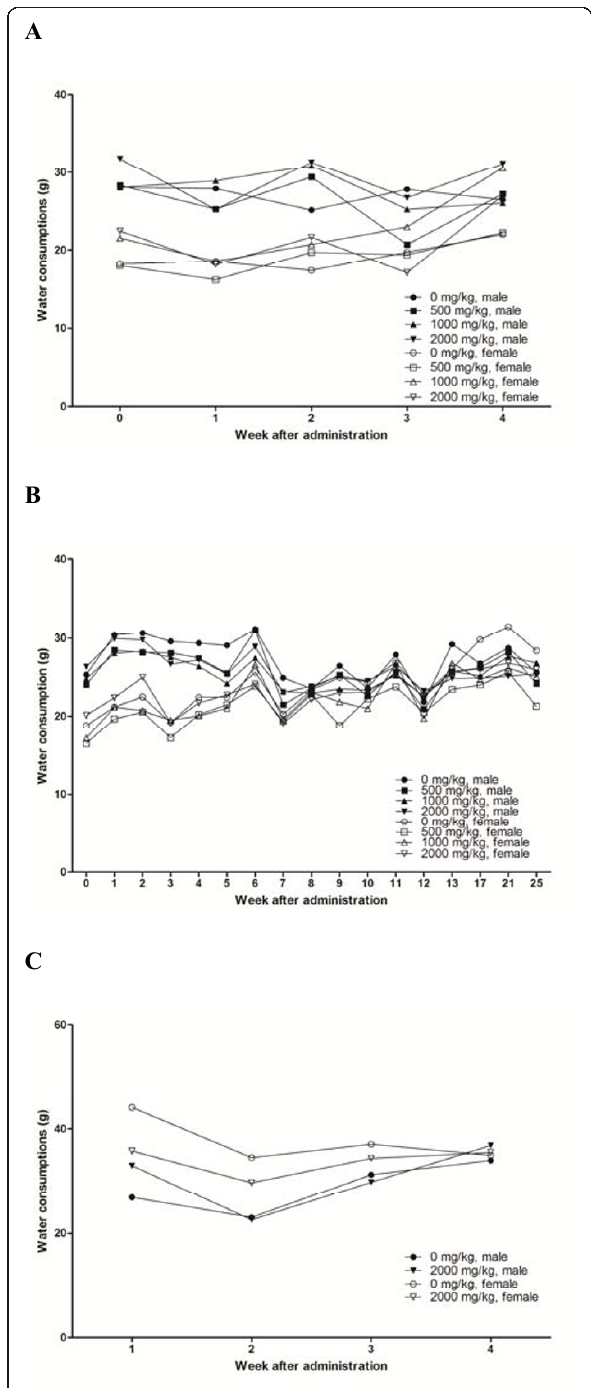
Figure 6 Mean water consumption by male and female rats treated with PM012 . Each data point represents the mean water consumption of groups of ten or fifteen animals. A) main group receiving 4 weeks of treatment, B) main group receiving 26 weeks of treatment and C) 4 weeks recovery group. Statistical analysis of the data (Dunnett ’ s test) revealed no significance differences between